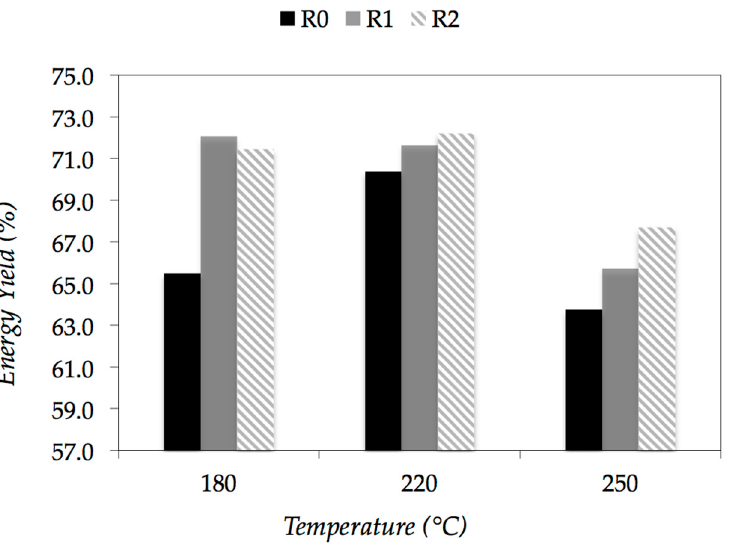
Figure 4. Effect of process water (PW) recirculation on hydrochars energy yield at the three tem- peratures investigated. tures